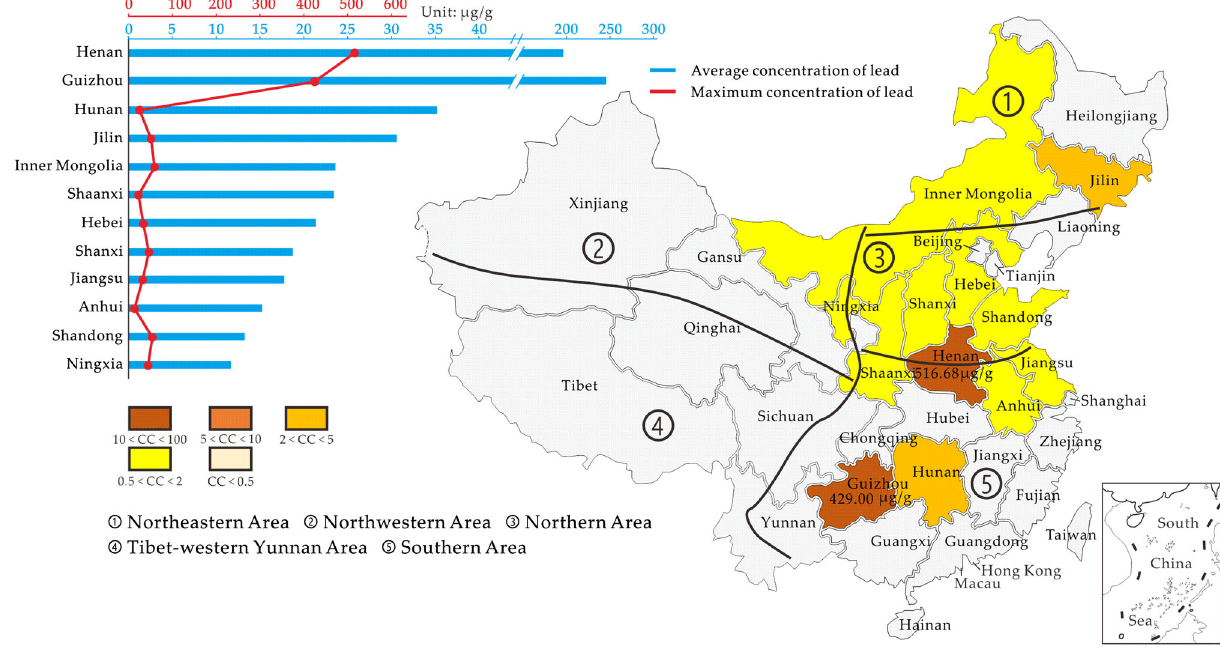
Fig. 3 Distribution of lead in Chinese coals from the late Carboniferous to Early Permian (C 2 –P 1 ) period. CC: concentration